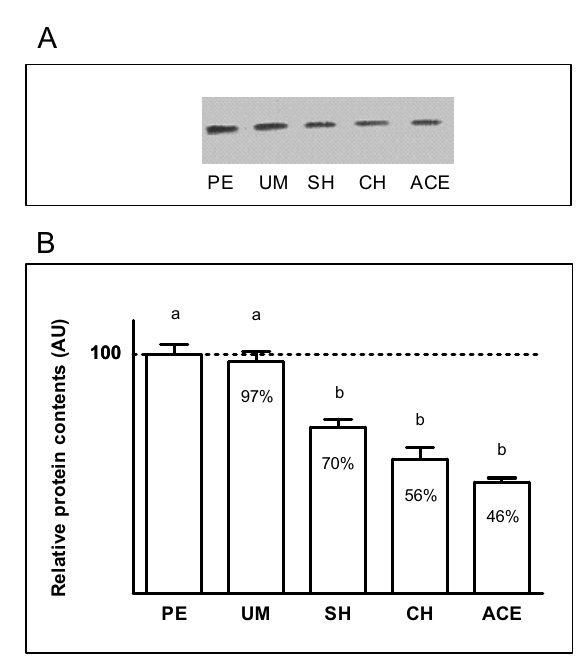
Fig. 4 – A. Relative protein contents. Example of Western blot im- munoassay for CuZnSOD in the endometrium of patients diagnosed with polypus endometrii (PE), uterus myomatosus (UM), simple hy- perplasia (SH), complex hyperplasia (CH) and adenocarcinoma en- dometrii (ACE). B. Comparison of relative SOD protein contents in endometrium patients diagnosed with polypus endometrii (PE), uterus myomatosus (UM), simple hyperplasia (SH), complex hyperplasia (CH) and adenocarcinoma endometrii (ACE). Values are expressed in arbitrary units (AU), as a percent of the protein content in PE patients which is considered as 100% (mean ± SEM). Values not designated by the same letter (a, b) are significantly different (p < 0 .